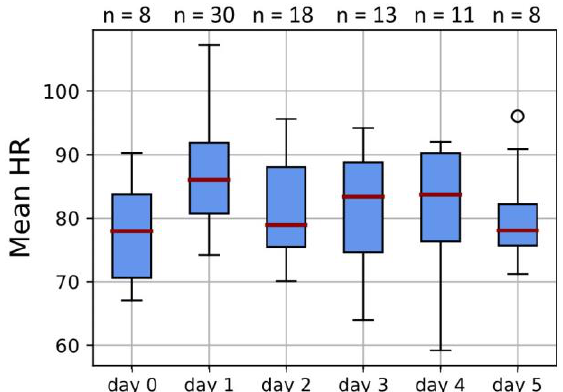
Figure A1. Boxplots of the HR of participants on days 0 to 5 , excluding all participants who were also administered nifedipine. Boxplots represent the median, interquartile range, and interdecile range of the values. Day 0 represents measurements taken before the first injection of betamethasone, while day 1 represents 24 h after the first injection, day 2 represents 48 h after the first injection, etc. The number of measurements incorporated into each day is displayed at the top of the graph.